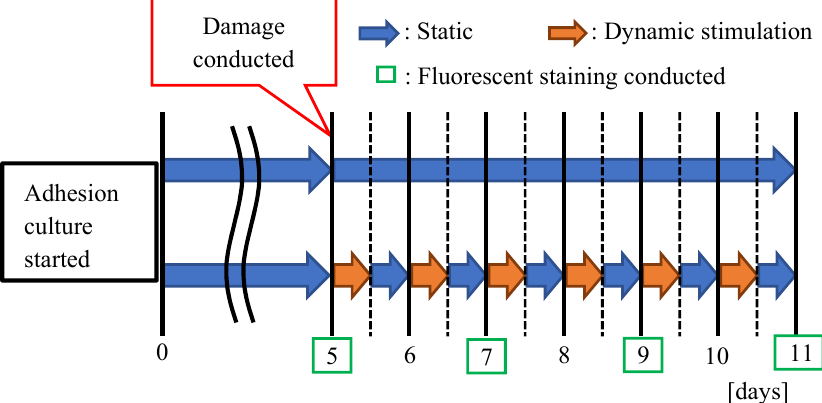
Figure 5. Experimental time scheme of reconstructing culture procedures of damaged neuronal cell colony by applying 12 h. Intermittent dynamic stimulations (vibration total amplitude: 60 µ m, frequency: 5 Hz, 12 h. interval) for 6 days along with completely static case for comparison. (4) At day 2, after the culture medium is aspirated out, plate B is removed so that the neurites are able to sprout freely to the right-hand direction, then a new culture medium is dispensed. Hereafter, the culture medium is changed every 48